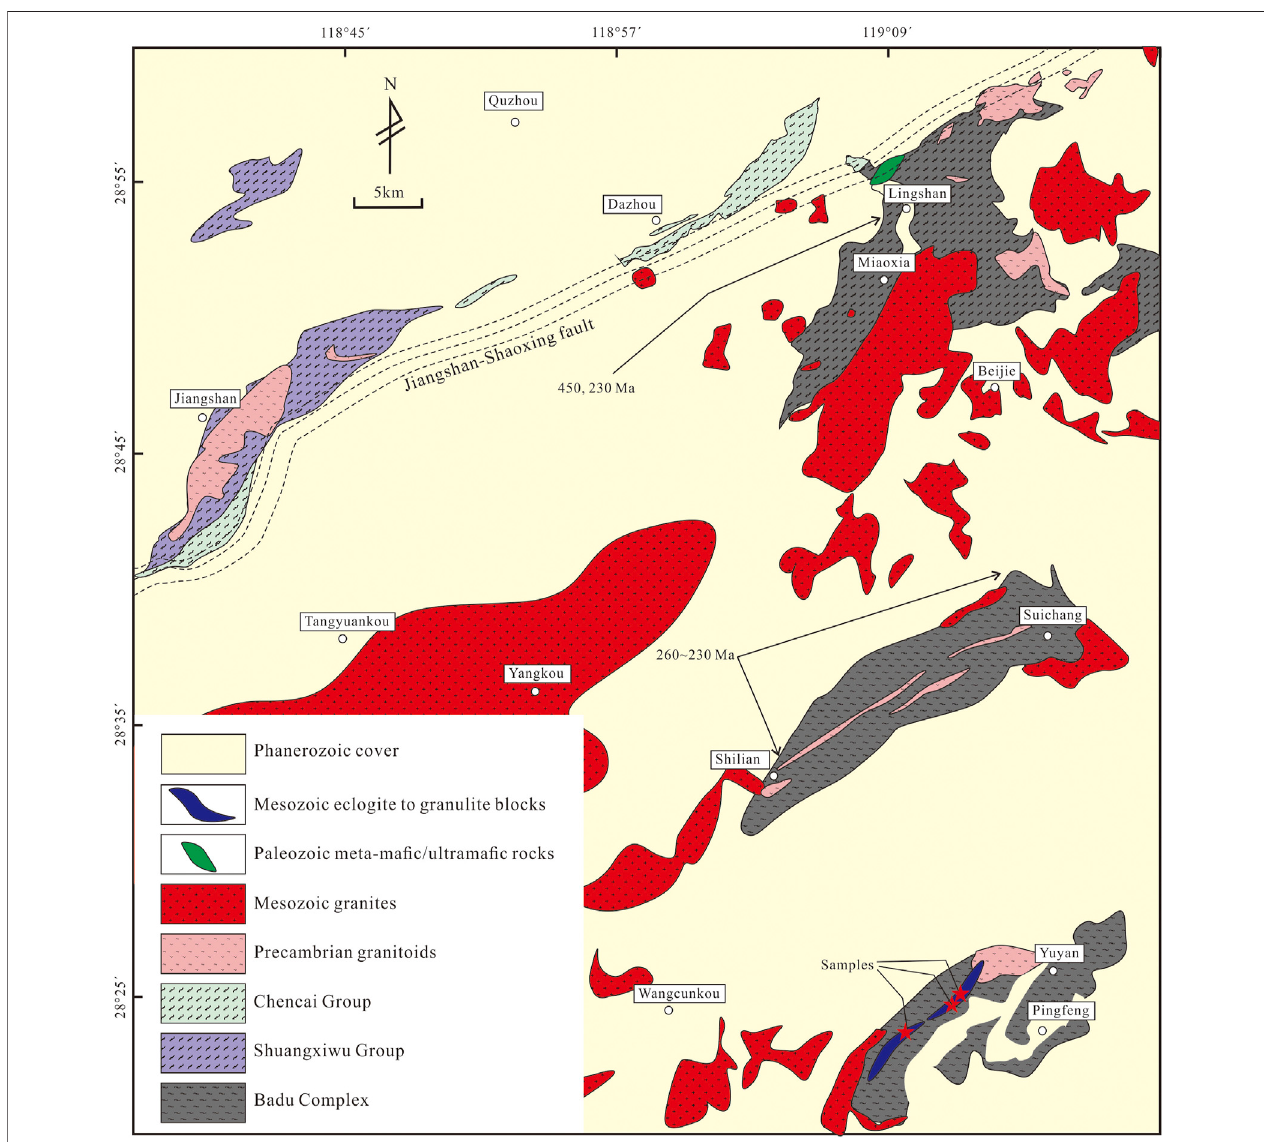
FIGURE 2 | Detailed geological map of the study area showing relations with the Jiang-Shao fault. Right to the south of the fault, both Caledonian and Indosinian metamorphism can be seen. Modi fi ed after (Zhejiang GBMR, 1980).